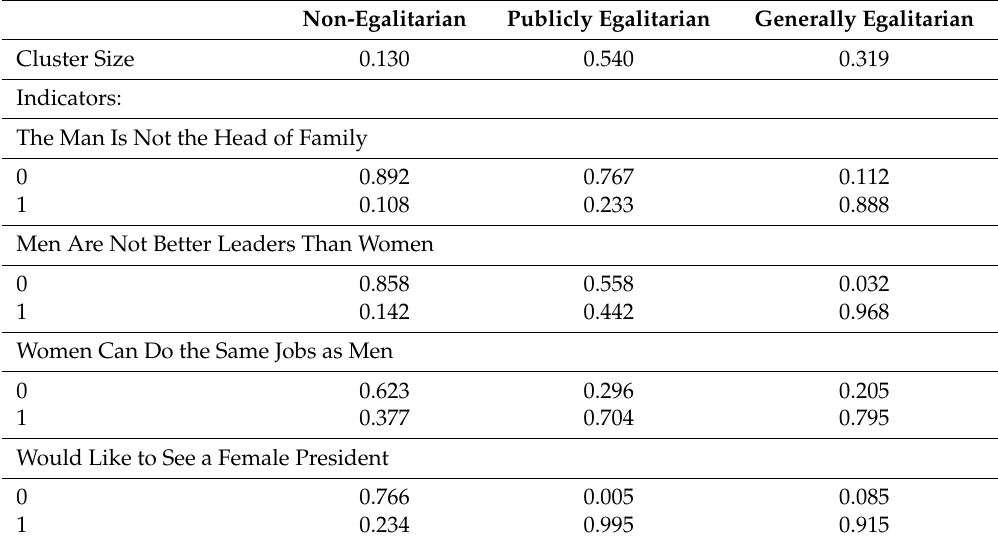
Table 3. Latent Class Analysis